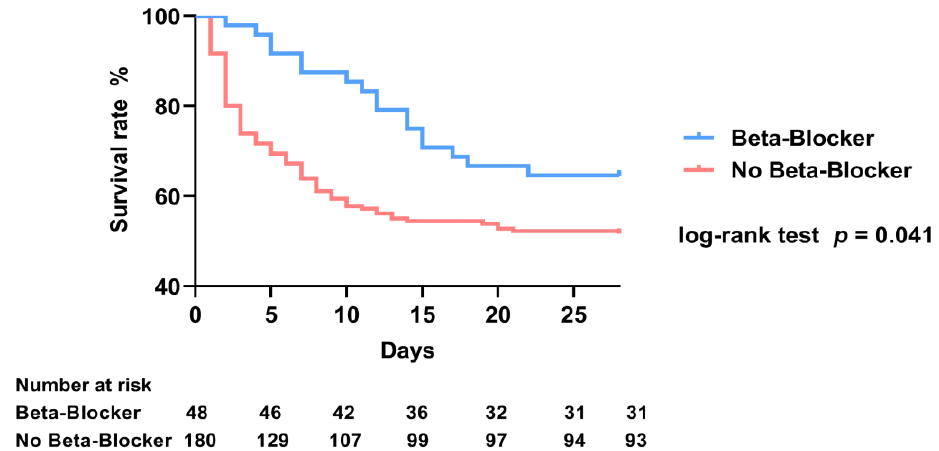
Figure 1. Kaplan–Meier survival curves of patients with sepsis-associated coagulopathy grouped by Figure 1. Kaplan – Meier survival curves of patients with sepsis-associated coagulopathy grouped the status of pre-existing long-term β -blocker therapy. Beta-Blocker: patients with sepsis-associated by the status of pre-existing long- term β -blocker therapy. Beta-Blocker: patients with sepsis-associ- coagulopathy treated with long-term β -blocker therapy before septic episodes. No Beta-Blocker: ated coagulopathy treated with long- term β -blocker therapy before septic episodes. No Beta-Blocker: patients with sepsis-associated coagulopathy treated without long-term β -blocker therapy before patients with sepsis-associated coagulopathy treated without long- term β -blocker therapy before septic septic episodes.